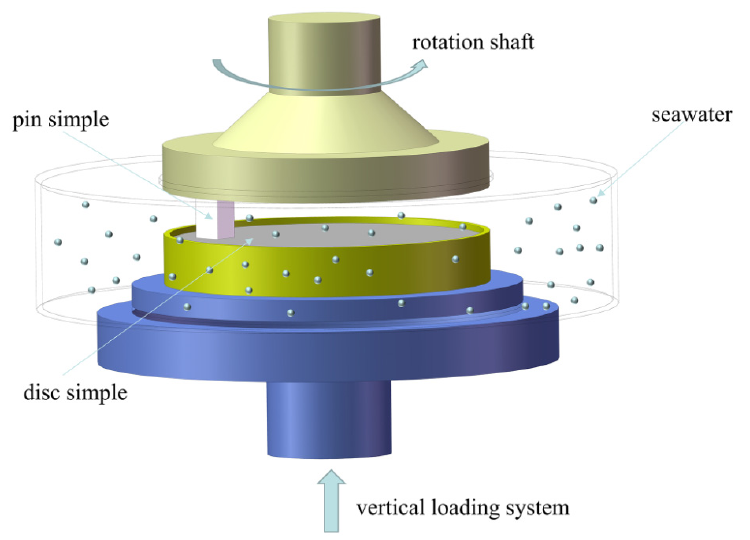
Figure 2. Schematic diagram of a pin-on-disc tester.